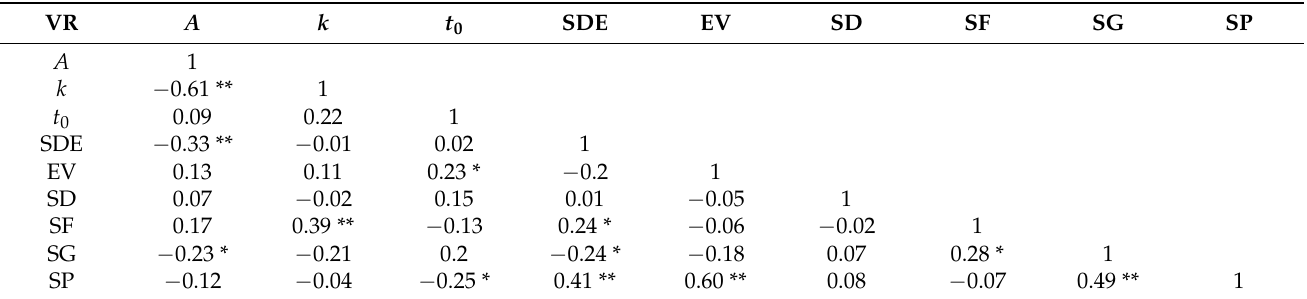
Table A3. Spearman’s partial rank correlation matrix between DBH–age curve parameters and topographic conditions. Variable (VR). DBH–age curve parameters as upper limit of growth ( A ); curvature of tree growth curve ( k ); time lag of tree growth ( t 0 ). Stand density (SDE). Elevation (EV).